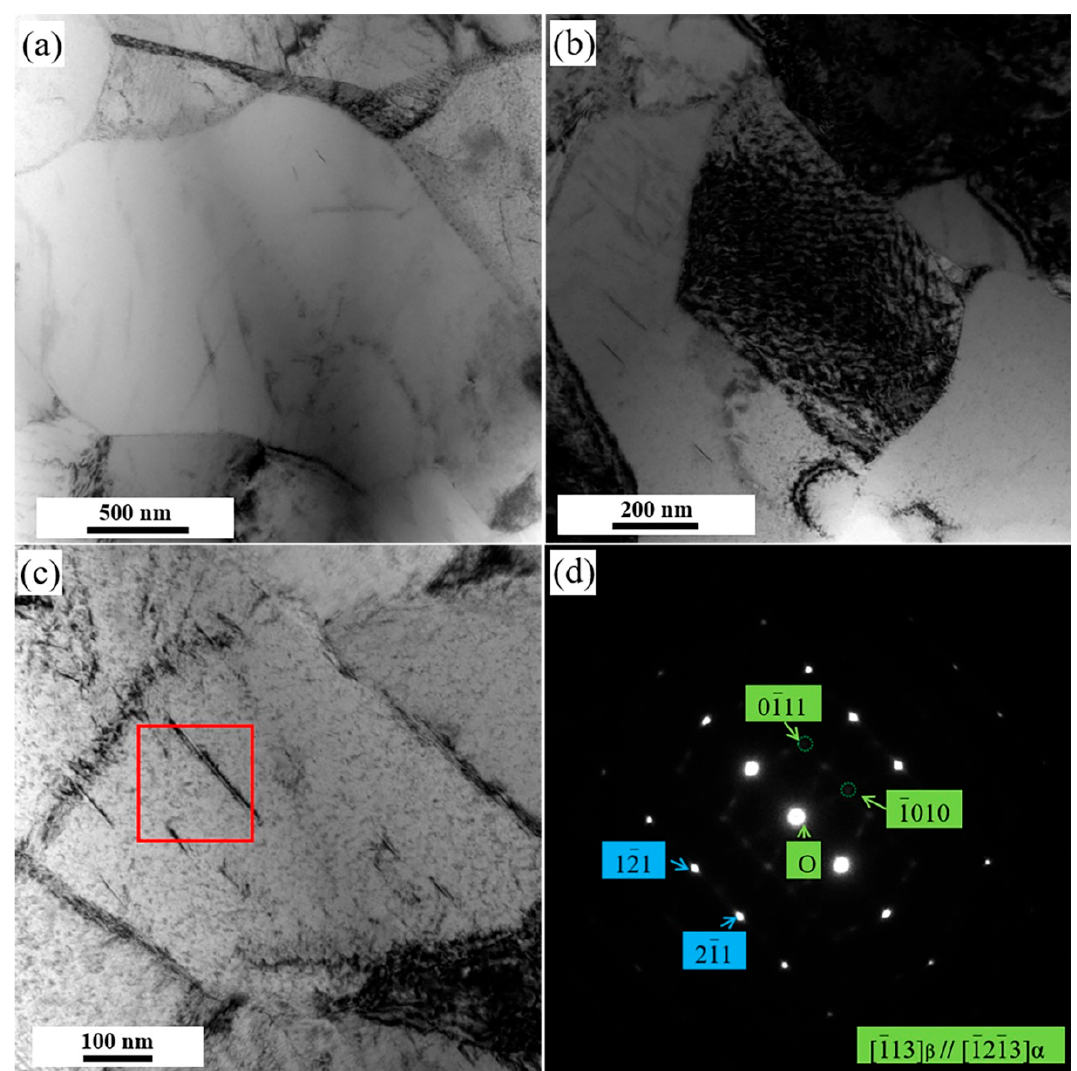
Figure 7 indicates TEM micrographs of Ti555211 alloy deformed at 850 ◦ C and a strain rate of 5 s − 1 . Similar to Ti555211 sample deformed at 750 ◦ C, α and β phases are observed in Ti555211 alloy deformed at 850 ◦ C. In the same manner, it can be observed that plenty of dislocations are observed in a few grains. This indicates that the grains are subjected to plastic deformation at 850 ◦ C, whereas dynamic recovery or dynamic recrystallization does not eliminate the dislocations in the grains as well.